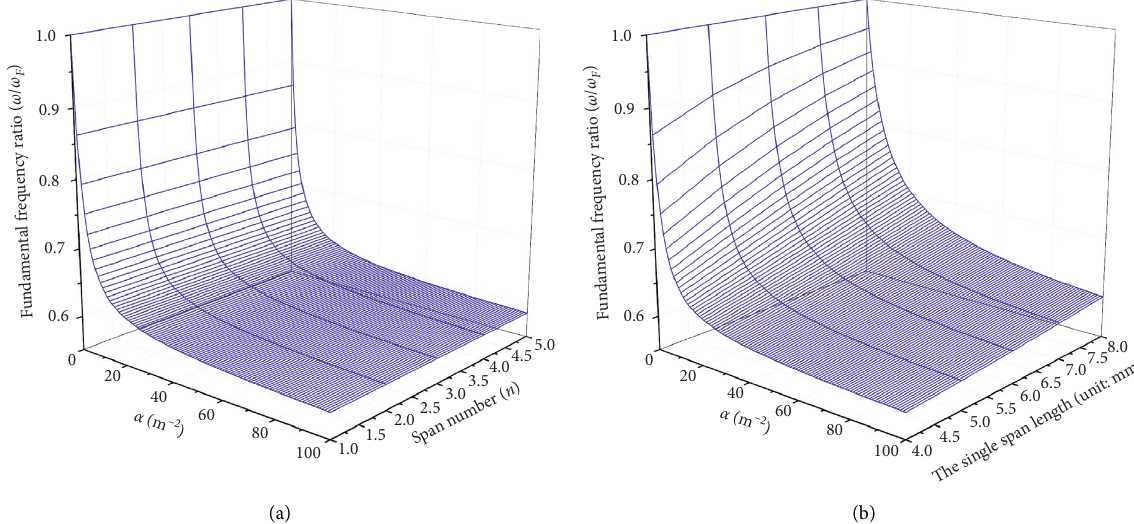
Figure 10: Values of ω / ω F of SCCCBs with different numbers of spans and single-span length. (a) The number of spans. (b) The single-span length.